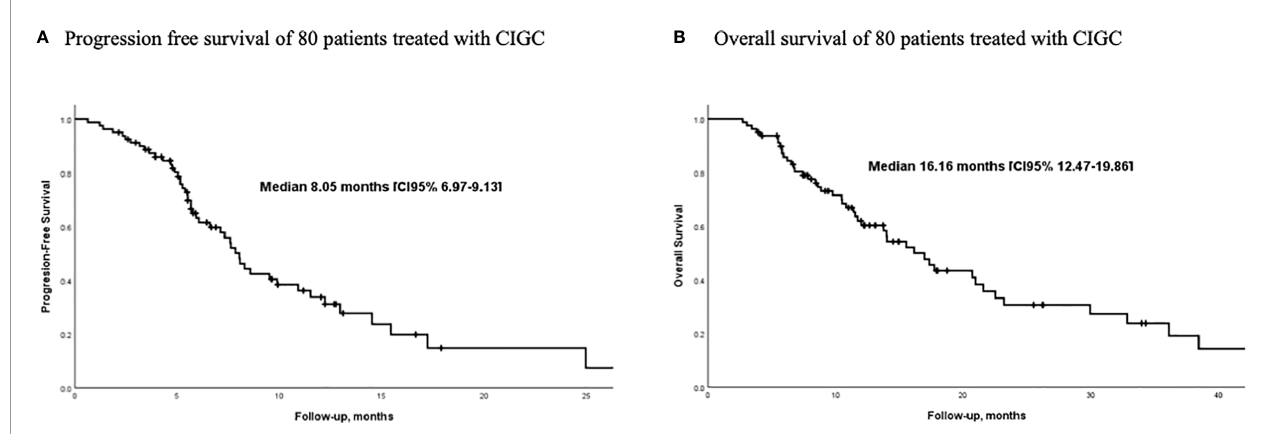
FIGURE 2 | Survival outcomes of patients with MPM treated with prolonged low-dose infusion of gemcitabine and cisplatin. (n=80) (A) Progression-free survival (B) Overall